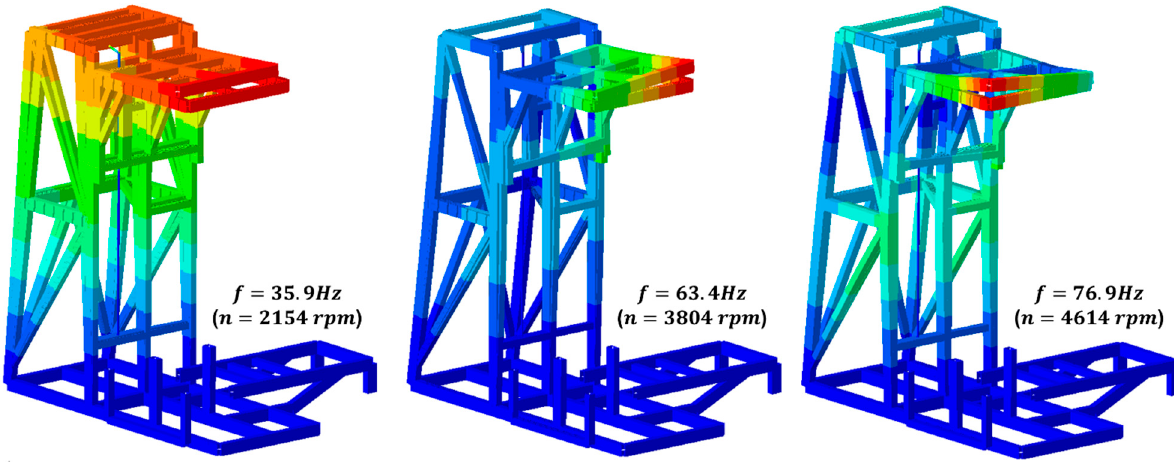
Figure 7. First mode shapes and corresponding resonant frequencies.